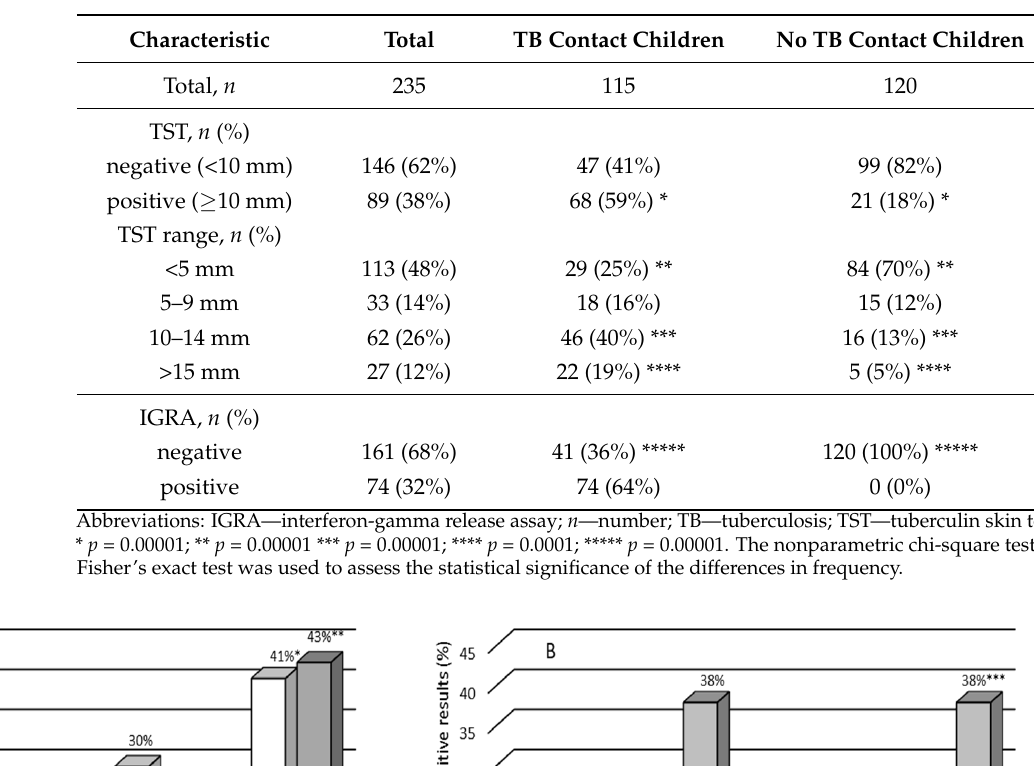
Table 2. Comparison of the tuberculin skin test (TST) and interferon-gamma release assay (IGRA) results among TB contact and no TB contact volunteers.